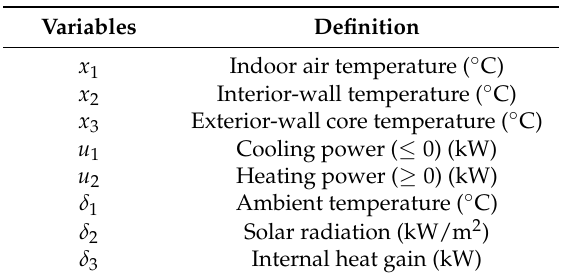
Table 1. Building parameter